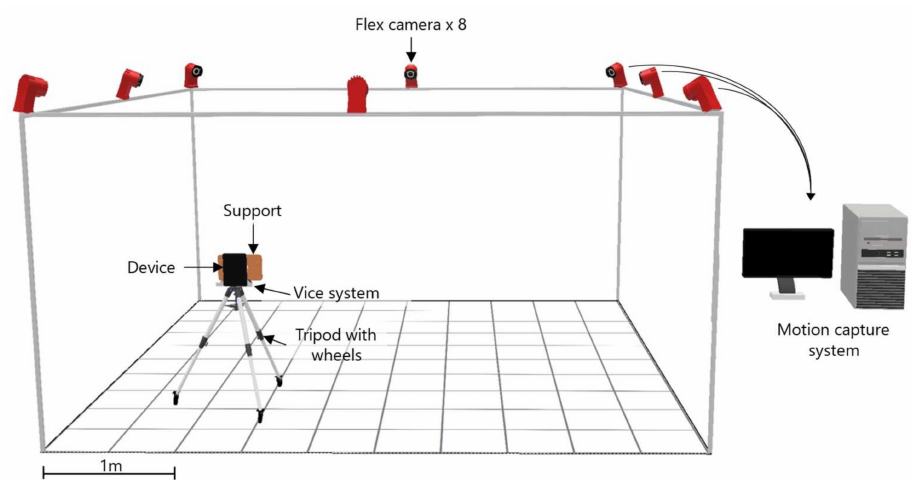
Figure 1. The experimental setup used during the experimentation